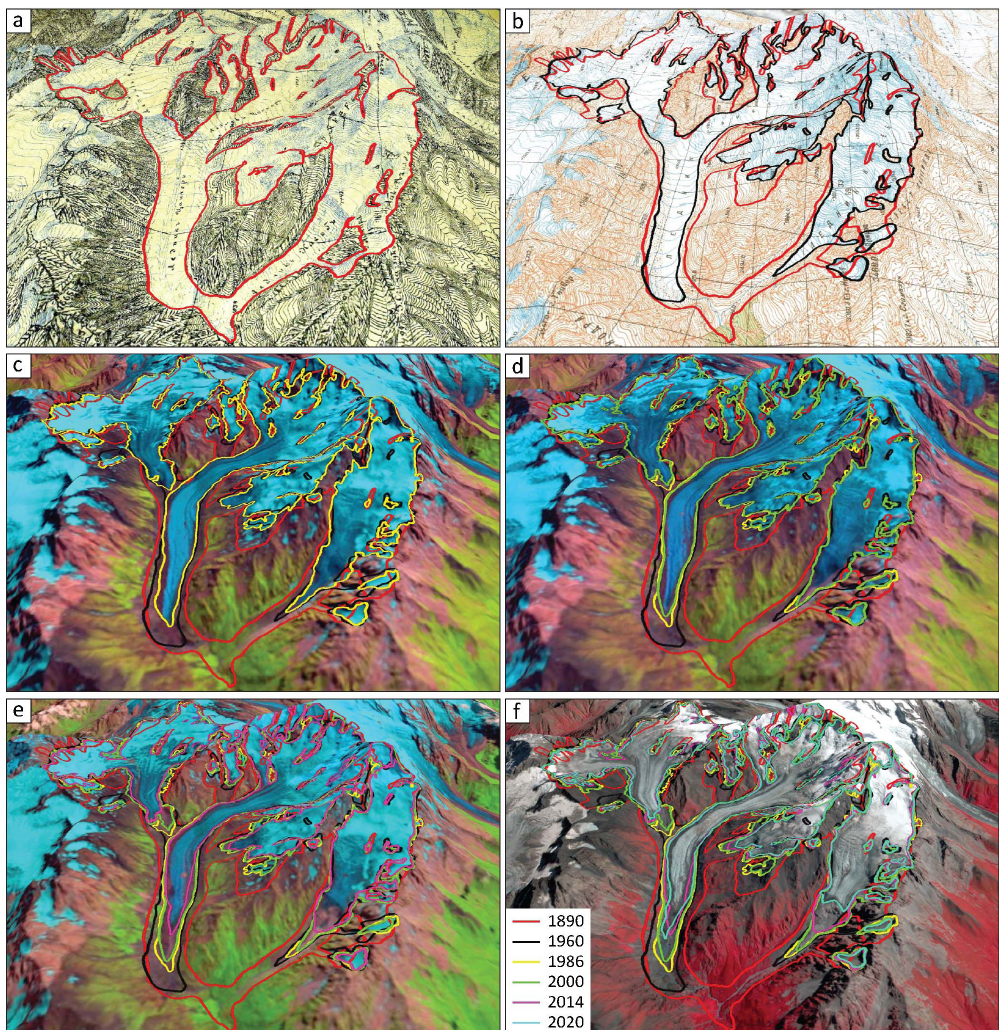
Figure 12. An example of a century-long area changes of Tsaneri Glacier (43 ◦ 3 (cid:48) 25.68 (cid:48)(cid:48) N 42 ◦ 59 (cid:48) 1.92 (cid:48)(cid:48) E) in 1890 (topographical map – X14, 1 : 42000) (a) ; 1960 (topographical map – k_38_27, 1 : 50000) (b) ; 1986 (Landsat 5 TM – 6 August 1986) (c) ; 2000 (Landsat 7 ETM + – 5 September 2000) (d) ; 2014 (Landsat 8 OLI – 3 August 2014) (e) ; and 2020 (Sentinel 2B – 11 September 2020) (f) . Outlines for 1890– 2014 were taken from Tielidze (2016). Image credits: Panels (c) , (d) , (e) : https://earthexplorer.usgs.gov (last access: November 2020); (f) Copernicus Sentinel data